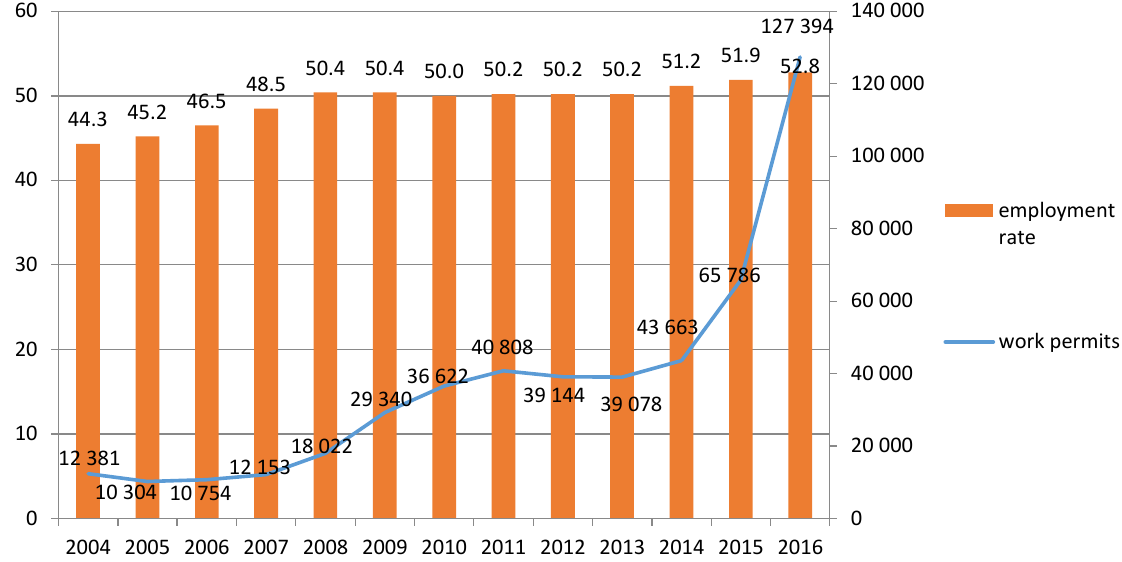
Figure 3. Work permits issued (right axis) and the employment rate (left axis) in Poland, 2004–2016